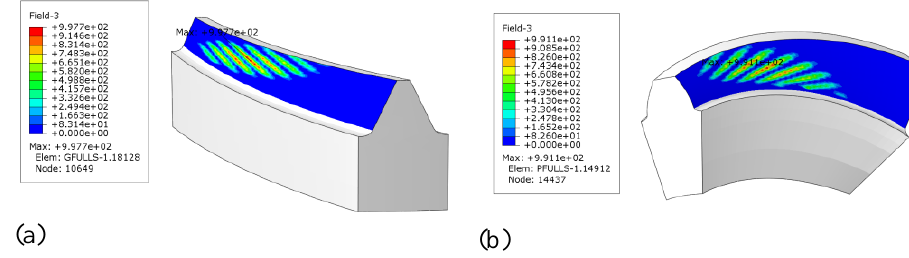
Figure 10. ( a ) Contact area on the gear; ( b ) Contact area on the pinion.